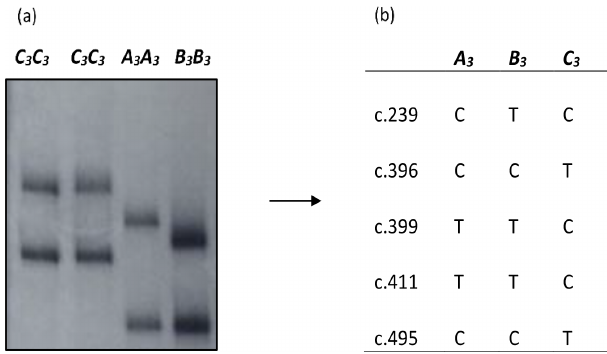
Figure 1. (a) PCR-SSCP banding patterns obtained in the exon 3/intron 2 region of bovine leptin gene investigated. (b) Nu- cleotide sequencing revealed the different nucleotide sequence vari- ations identified in the region